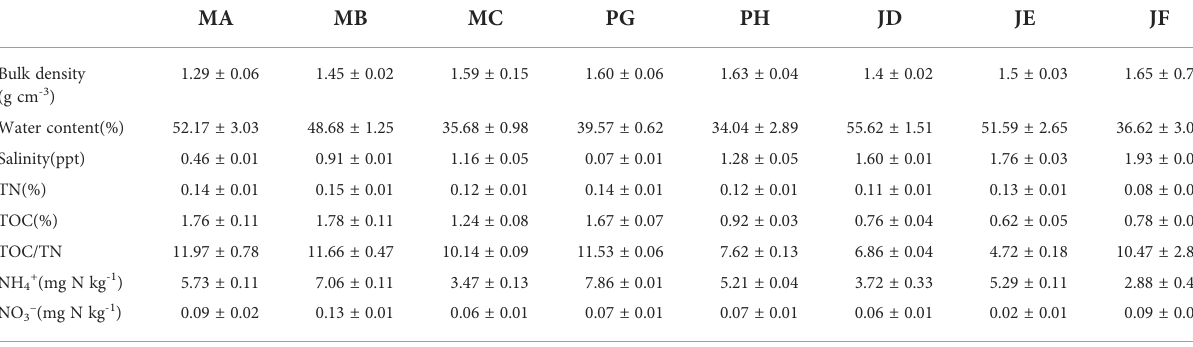
TABLE 1 Environmental parameters in surface sediments of the shrimp ponds.